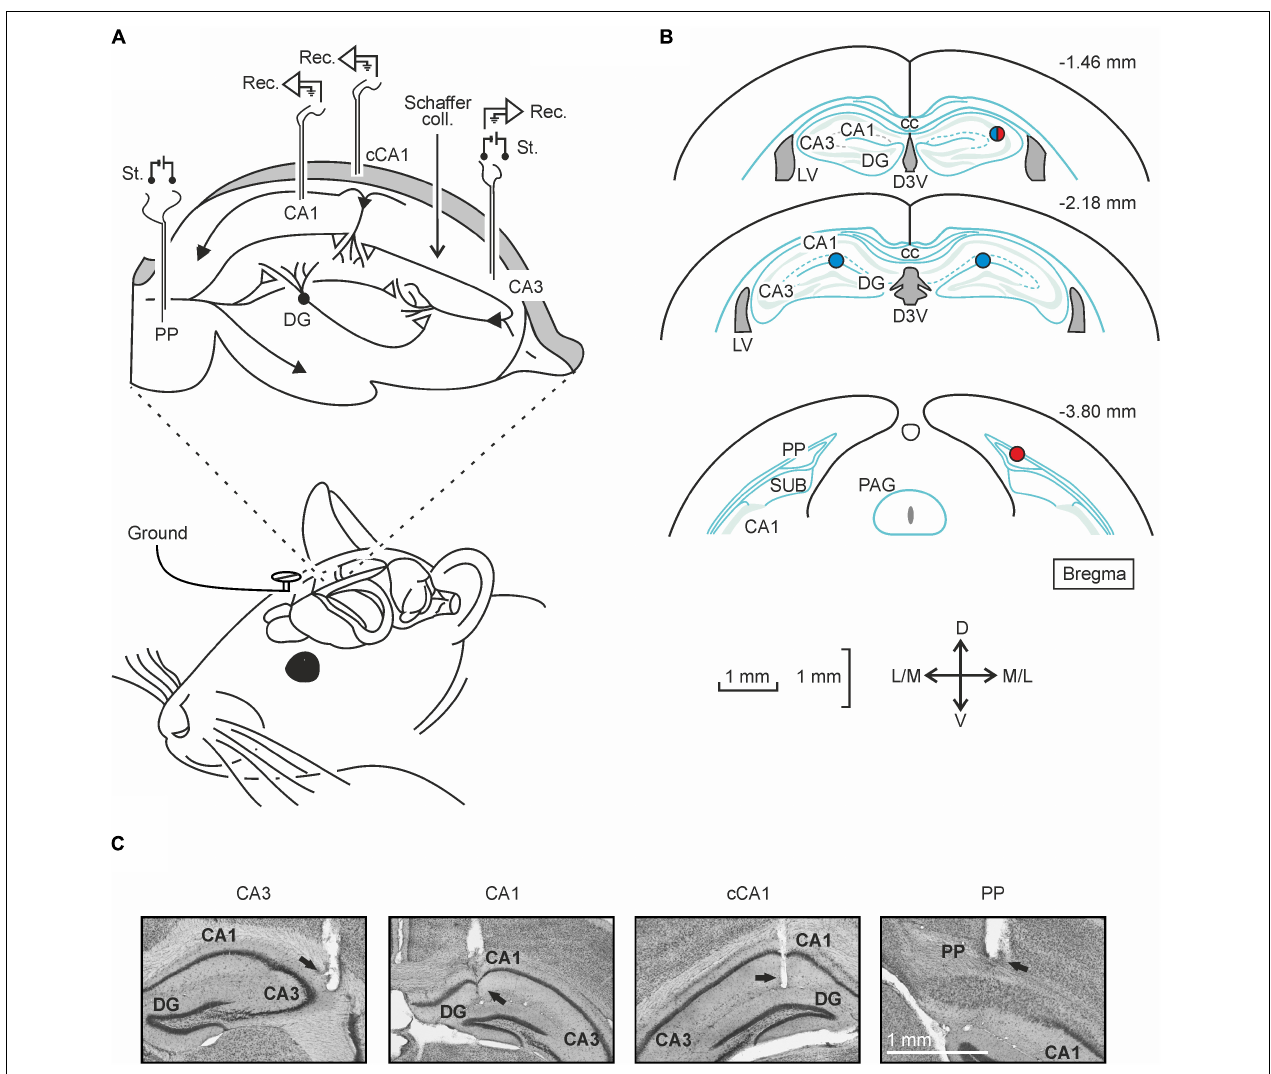
FIGURE 5 | Experimental design. (A) Mice were implanted with bipolar stimulating (St.) electrodes in the perforant pathway (PP) and the hippocampal CA3 area, and with recording (Rec.) electrodes in the hippocampal CA1 areas of both hemispheres. A bare silver wire was affixed to the occipital bone as a ground. (B) A diagrammatic representation of three coronal slices of mouse brain (Franklin and Paxinos, 2007) illustrating stimulation (red) and recording (blue) sites. (C) Representative micrographs illustrating the final location of stimulating and recording electrodes indicated with a black arrow. Scale bar is indicated at the bottom right. D, L, M, and V stand for dorsal, lateral, medial, and ventral, respectively; PP, perforant pathway; DG, dentate gyrus; Schaffer coll, Schaffer collaterals; CA3, cornu ammonis -3; CA1, homolateral cornu ammonis -1; and cCA1, contralateral cornu ammonis